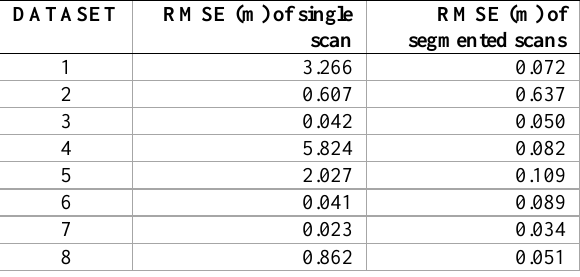
Table 3: RMSE of the similarity transformation between the